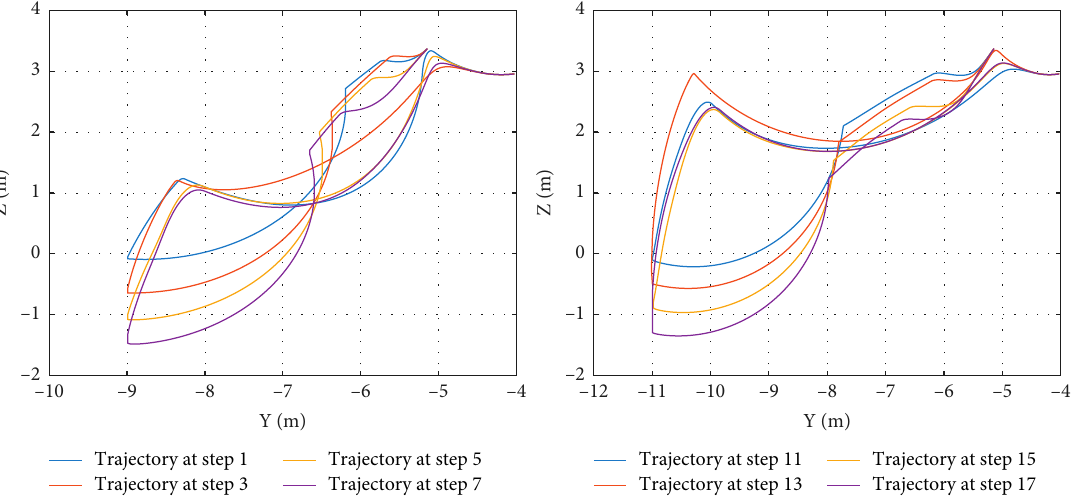
Figure 10: Trajectory in several excavating periods.